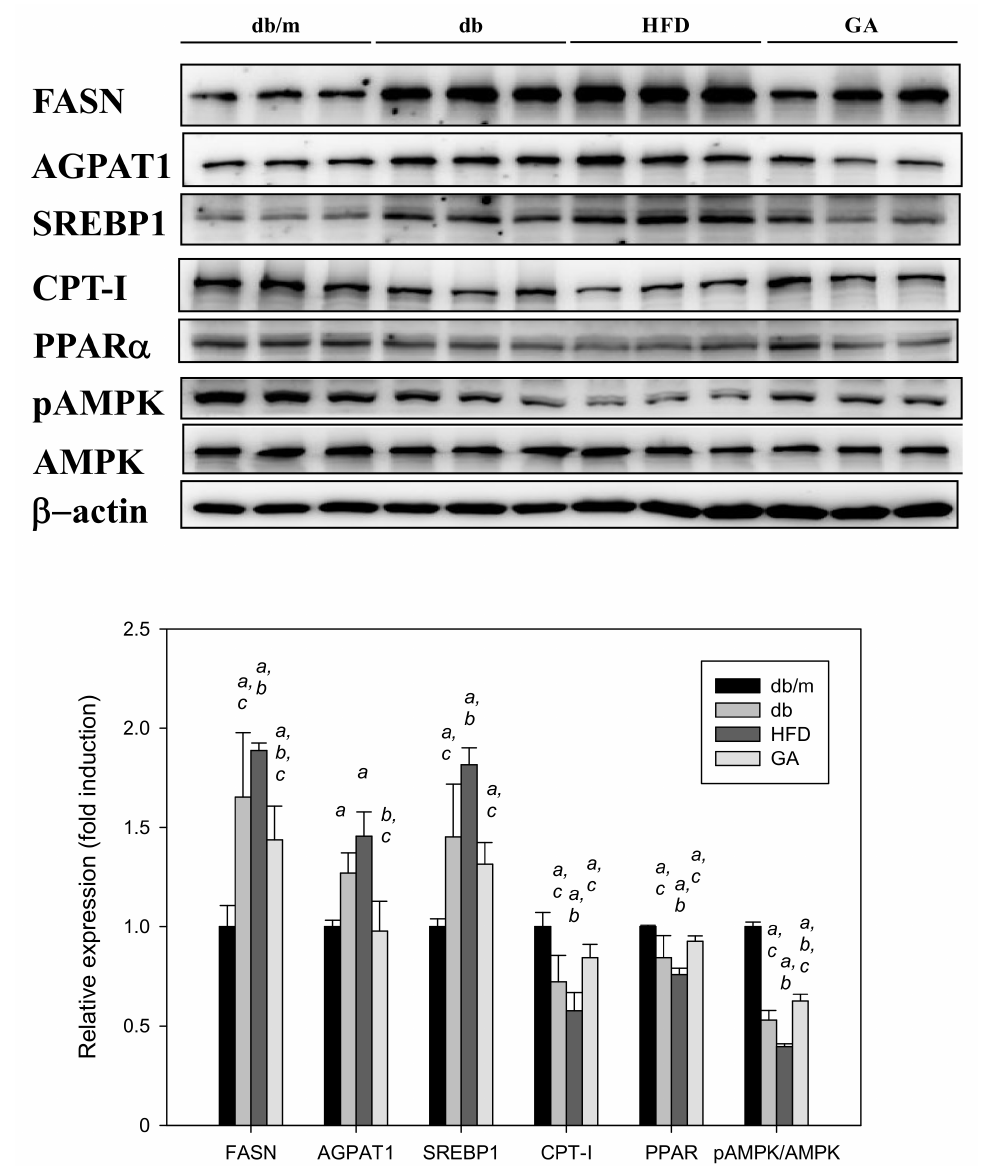
Figure 4. HFD induced and GA inhibited the expression of hepatic lipid metabolism–related proteins in diabetic mice. 6-week-old male db/db mice fed with HFD and 100 mg/kg GA for 12 weeks. After euthanization, liver tissue samples were obtained for determination with SREBP1 and FASN antibodies. db/m, age-matched heterozygous mice fed with standard diet; db, db/db mice fed with standard diet; HFD, db/db mice fed with HFD; GA, db/db mice fed with HFD and GA. a, p < 0.05 compared with the db/m control group. b, p < 0.05 compared with the db group. c, p < 0.05 compared with the HFD